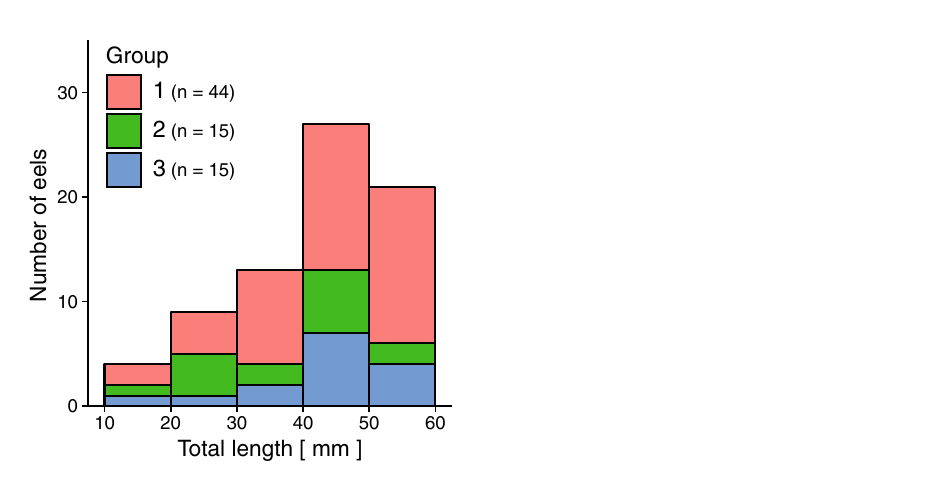
Figure 7. Histogram of eel larvae numbers at different size classes. Colors denote three cluster groups based on eukaryotic composition in the gut content samples in Fig. 5. Data are also available in Supplementary Table